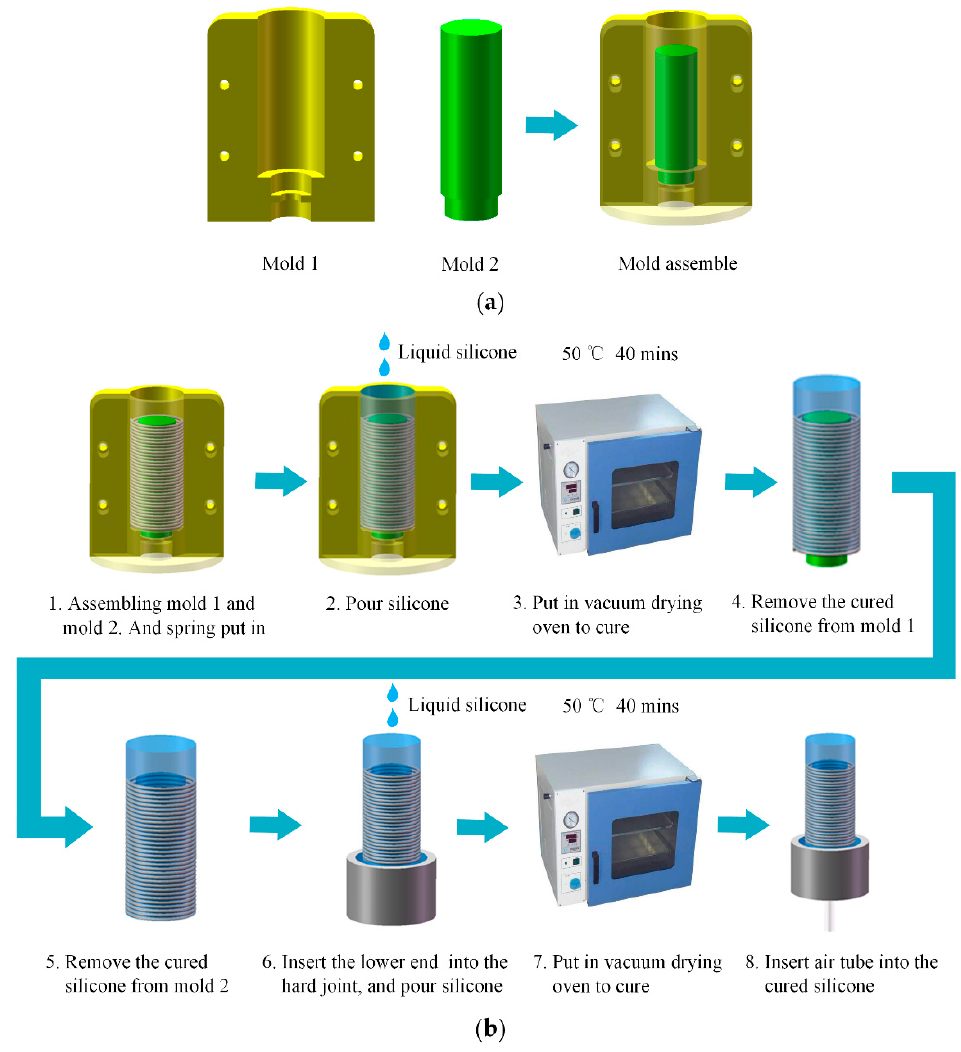
Figure 3. Fabrication of the soft actuator: ( a ) casting molds of the soft actuator; ( b ) fabrication pro- cedure of the soft actuator.